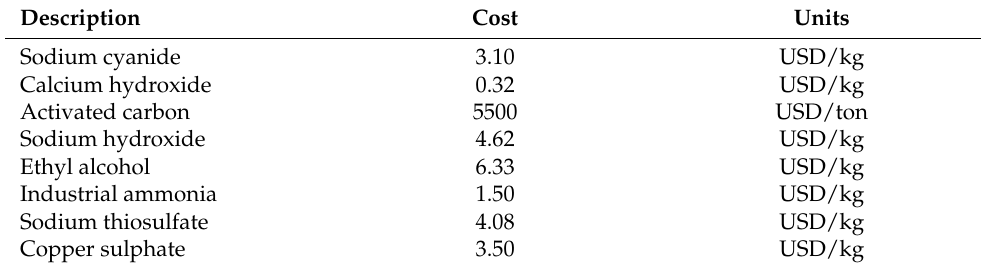
Table 7. Prices of reagents and other required